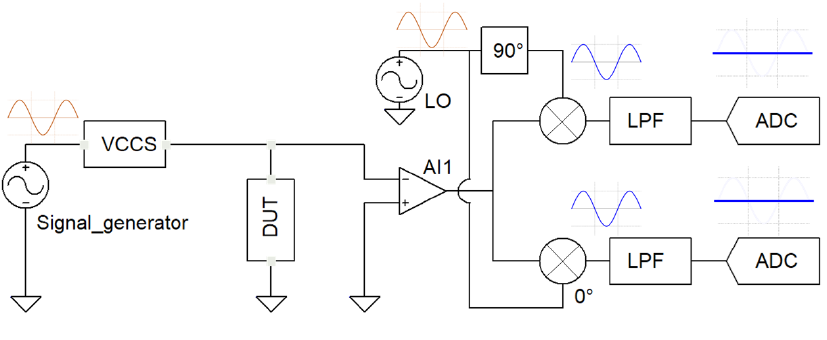
Figure 2. I/Q demodulation measurement